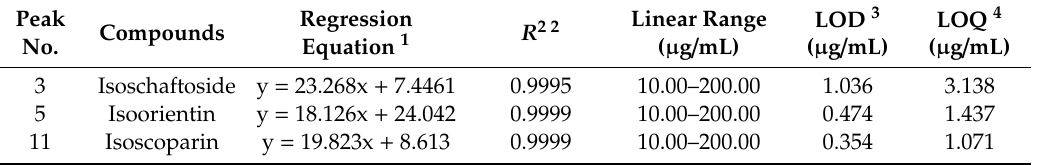
Table 2. Linear regression and LOD and LOQ values for the three representative flavonoids identified from the wheat sprout